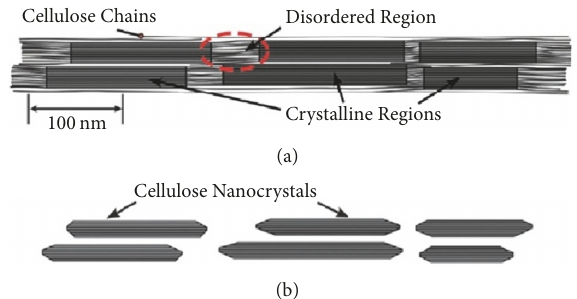
Figure 1: Schematic diagram of CNCs prepared by acid hydrolysis: (a) idealized cellulose microfibril showing one of the suggested con- figurations of the crystalline and amorphous regions and (b) CNCs after acid hydrolysis dissolved the disordered regions. Adapted from